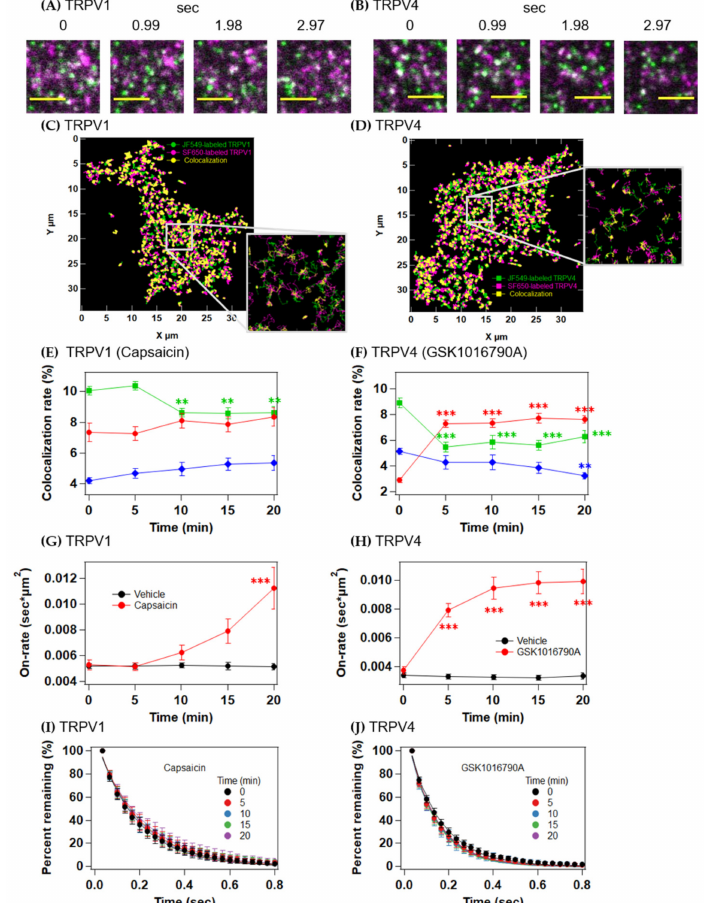
Figure 5. Colocalization analysis of TRPV1 and TRPV4 upon activation. ( A , B ) Representative images of the colocalization of JF549-labeled TRPV1 (green) and SF650-labeled TRPV1 (magenta) ( A ) and JF549-labeled TRPV4 (green) and SF650-labeled TRPV4 (magenta) ( B ). Colocalized bright spots appear to be white. Scale bars, 3 µ m. ( C , D ) Trajectories of colocalized TRPV1 molecules ( C ) and TRPV4 molecules ( D ). ( E , F ) Time-dependent changes in the colocalized fractions of the diffusion states. TRPV1 after capsaicin stimulation ( E ), TRPV4 after GSK1016790A stimulation ( F ). ( G , H ) On-rate constants of JF549-labeled TRPV1 ( G ) and JF549-labeled TRPV4 ( H ) after stimulation with vehicle (black) or agonist (red). ( I , J ) Time-dependent changes in the percentage of TRPV1 remaining ( I ) and TRPV4 remaining ( J ) upon activation. Data are means ± SEM of 17–22 cells. ** p < 0.01, *** p < 0.001 (one-way ANOVA followed by Dunnett’s multiple-comparisons test versus the basal level (0